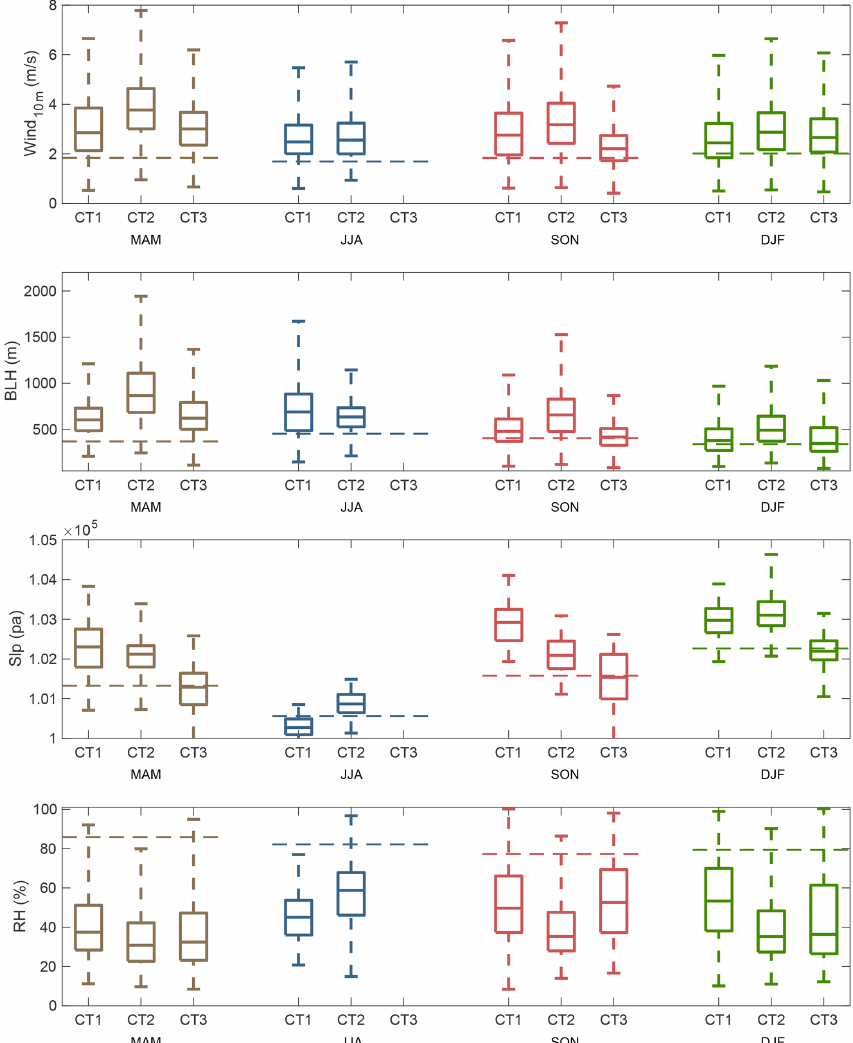
Figure 7. Boxplot of surface wind speed, boundary layer height (BLH), sea level pressure (slp) and relative humidity (RH) for each circulation type. The dashed line indicates the seasonal mean of the specific variables. The mean values of all of the meteorological variables in each CT are significantly different with their seasonal mean based on a two-tailed Student’s t test at a significance level of